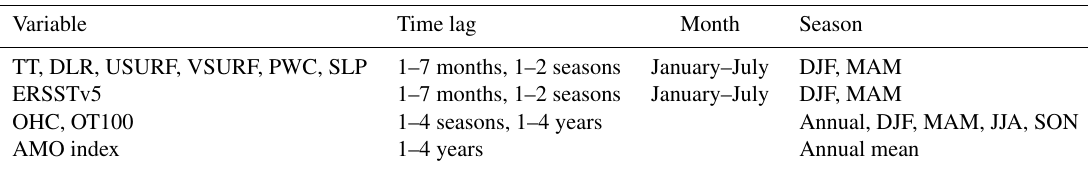
Table 2. Time lags used for the forecast of SSIE. Seasonal averages are indicated as winter (December/January/February – DJF), spring (March/April/May – MAM), summer (JJA – June/July/August) and autumn (September/October/December – SON). Variable Time lag Month Season TT, DLR, USURF, VSURF, PWC,